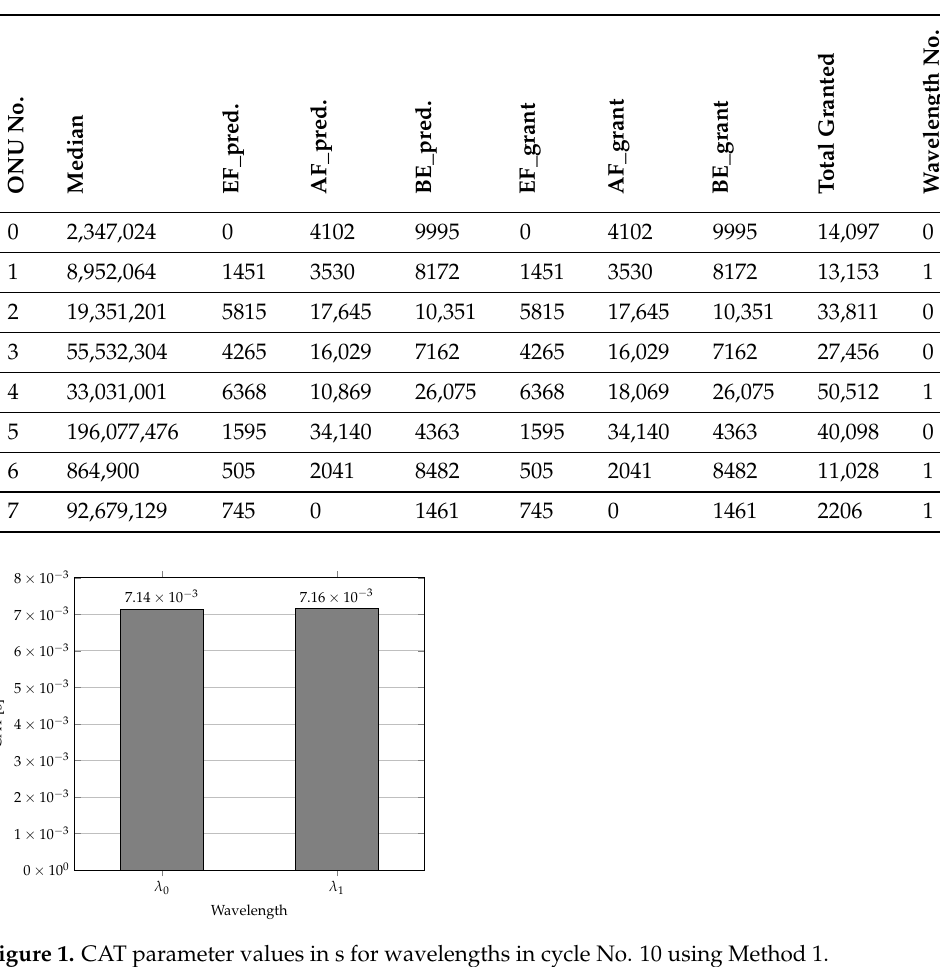
Table 2. Example of the wavelength allocation for actual data transmission demands in bytes from 8 ONUs in cycle No. 10 using Method 1.